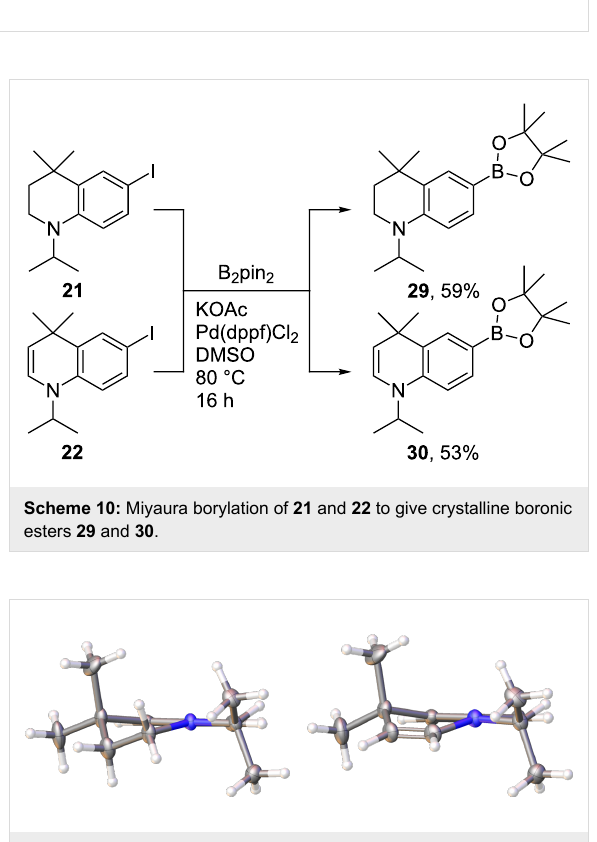
Figure 4: Comparison of the crystal structures of 29 (left) and 30 (right) as viewed along the plane of the aromatic ring, with the pinaco- late ester groups removed for clarity. DHQ 30 exhibits a more planar structure. Compounds 29 and 30 were visualised using Olex2